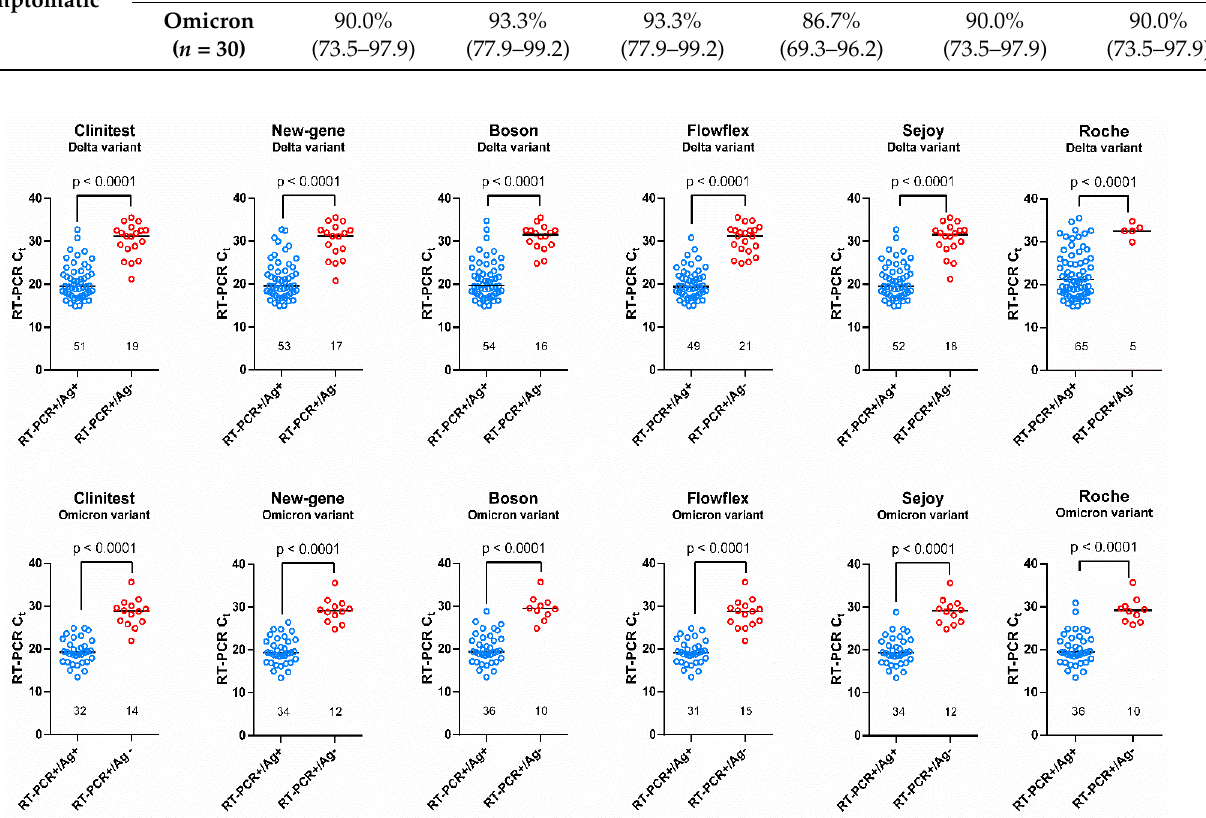
Figure 1. Graphical representation of positive and negative antigen results according to RT-qPCR Ct values. A significant difference in the Ct value was observed between the positive and negative tests for each RAD test.